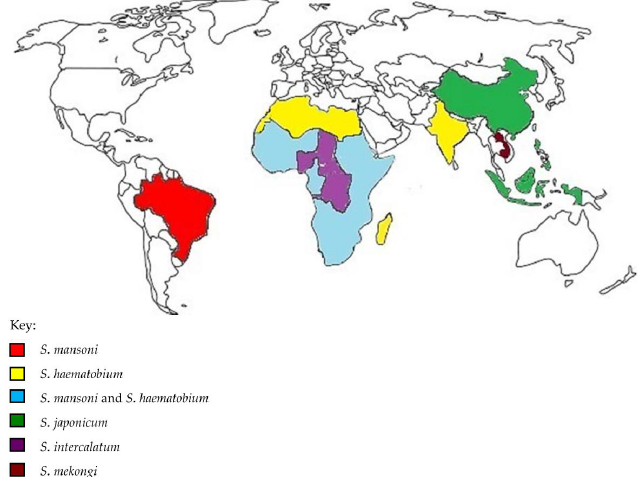
Figure 1. Geographical distribution of the different schistosome species. Each of these species has their own geographic pattern: Schistosoma mansoni ( S. mansoni )infection mostly occurring in sub-Saharan Africa, the Middle East, South America; Schistosoma intercalatum ( S. intercalatum )in Congo, Nigeria, Chad and Central African Republic; Schistosoma haematobium ( S. haematobium ) is mostly prominent in sub-Saharan Africa, North Africa, Middle East, India and the islands of Madagascar and Mauritius; Schistosoma japonicum ( S. japonicum ) is endemic to Asian countries only such as China, Philippines and Indonesia and finally Schistosoma mekongi ( S. mekongi ) is found exclusively in Laos and Cambodia.